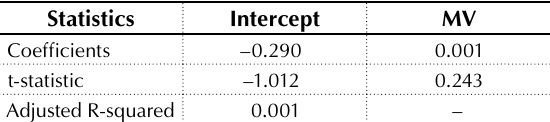
Table 6. The cross-sectional regression of 2018 MVA’s change and market value